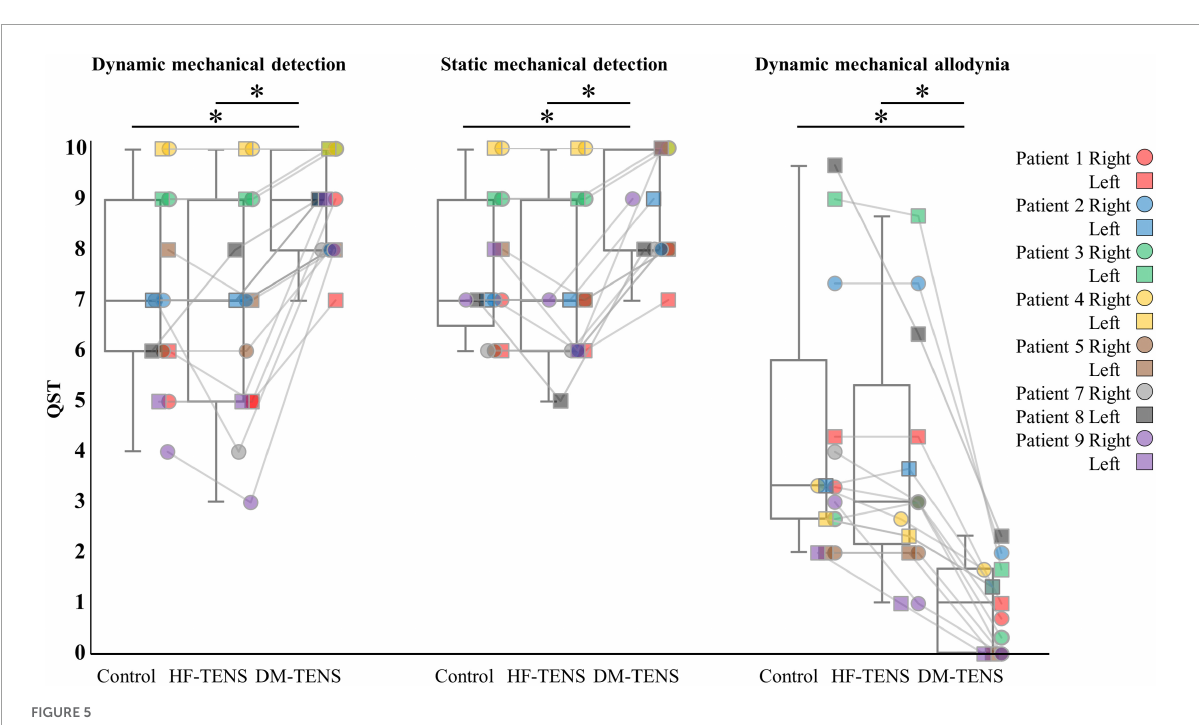
FIGURE5 The specific items of the QST for each patient. * p <